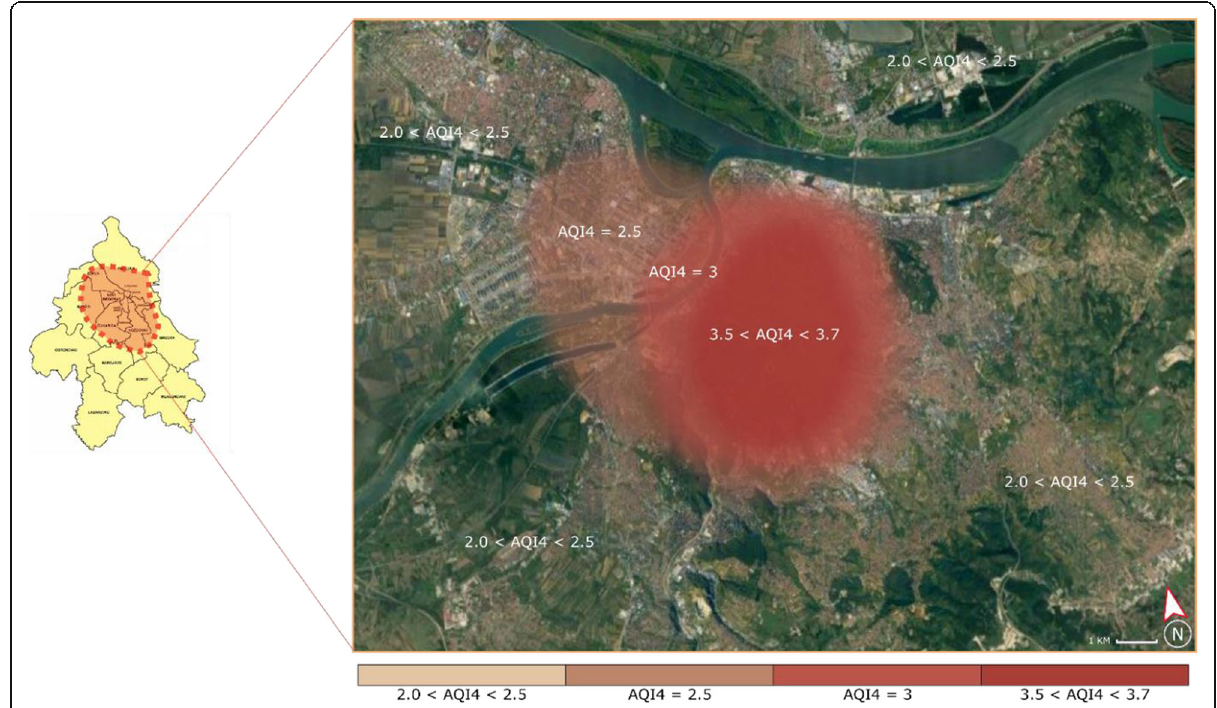
Fig. 5 The air quality index in Belgrade – average values for the period from May 2019 to May